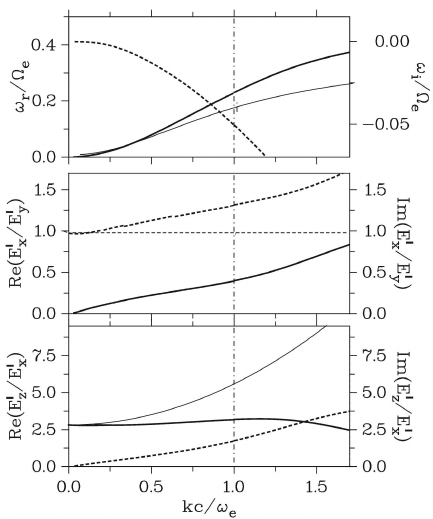
Fig. 6. Dispersion and polarization of whistler waves: θ = 70 ◦ , β e = 0 . 2. From top to bottom: frequency and amplitude ratios ( E 0 z /E 0 x ) and ( E 0 x /E 0 y ) representing the polarization in the z 0 -x 0 and x 0 -z 0 plane, respectively. Note, that the polarization has been calcu- lated in a coordinate system in which the k -vector is directed along the (new) z 0 -axis, which is rotated by the angle θ with respect to the magnetic field direction. Solid (thick) lines mark the real parts, dashed lines the imaginary parts of the three complex quantities. The thin (solid and dashed) lines denote the outcome of cold plasma